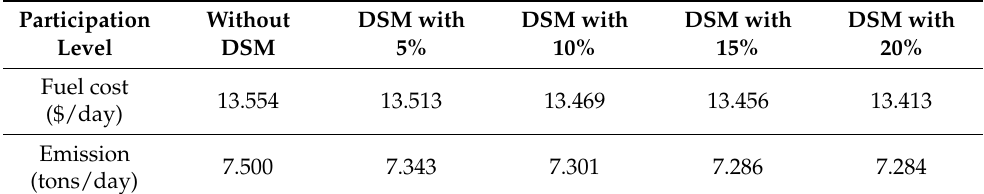
Table 2. Dynamic economical dispatch with various participation levels of DSM.